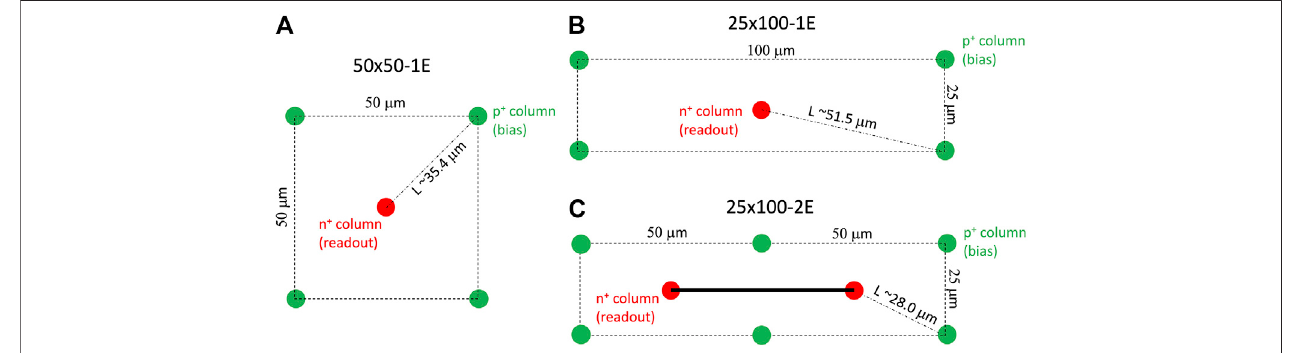
FIGURE 2 | Conceptual design of small-pitch 3D pixels for the ATLAS and CMS upgrades at HL-LHC, also indicating the values of the inter-electrode distance L. (A) 50 × 50 – 1E; (B) 25 × 100 – 1E; (C) 25 × 100 −